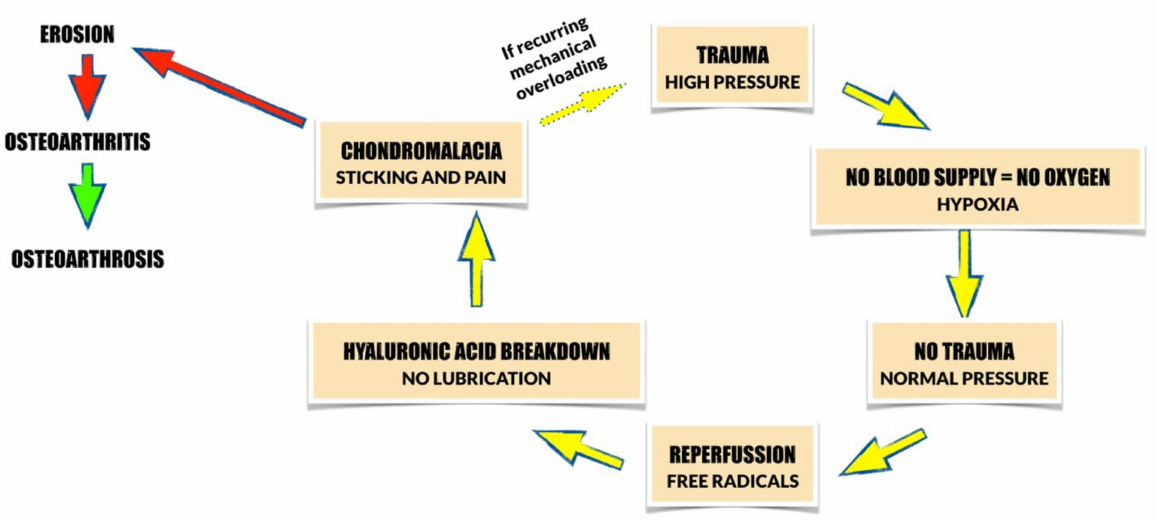
Figure 1. Schematic changes that occur within TMJs due to mechanical overloading based on the literature [8]. Yellow arrow: reversible progression; red arrow: irreversible progression; green arrow: